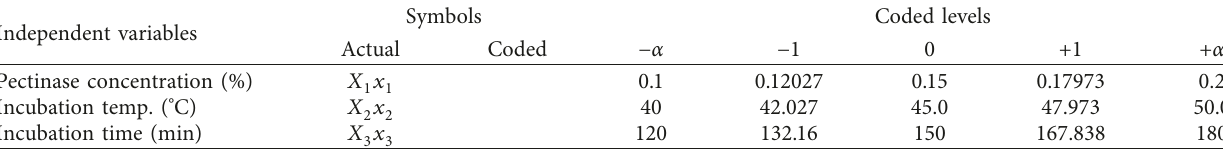
Table 1: Obtained levels of processing variables in design.